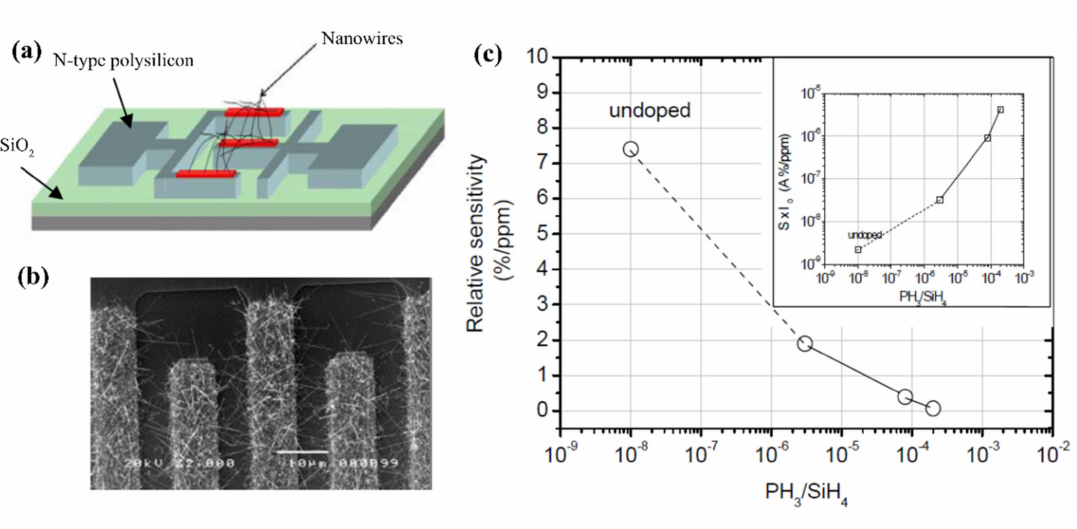
Figure 10. ( a ) Schematic view and ( b ) SEM image of the inter-digitated comb-shaped SiNWs based sensor. ( c )Relativesensitivitytoammoniadetectionversusthephosphinetosilaneratio(theinsertshows the e ff ect of the doping level on the sensitivity to ammonia detection molecules). Reproduced from [136], with permission from John Wiley and Sons,